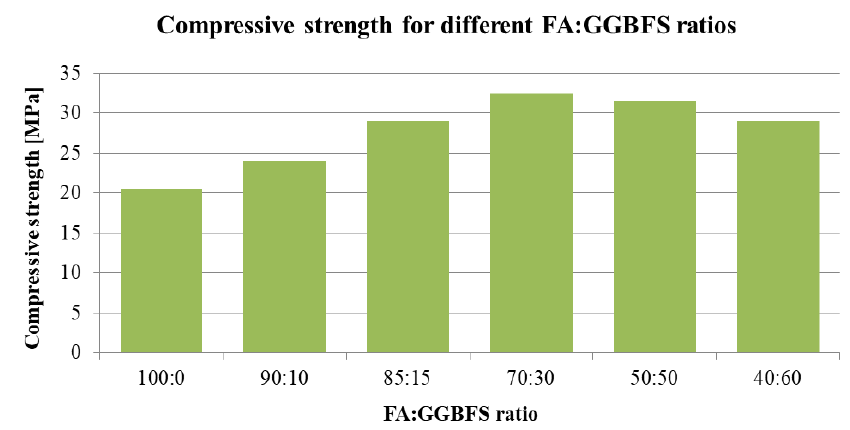
Figure 1. Effect of slag ratio variation on the compressive strength of the geopolymer material [22]. Decreases of 3.43% and 6.33% in the compressive strength were also observed for the 50:50 and 40:60 mixtures when compared to the 70:30 mixtures and the 50:50 mixtures, respectively. This phenomenon could be a sign of a low geopolymerization process; therefore, lower mechanical properties have been achieved.